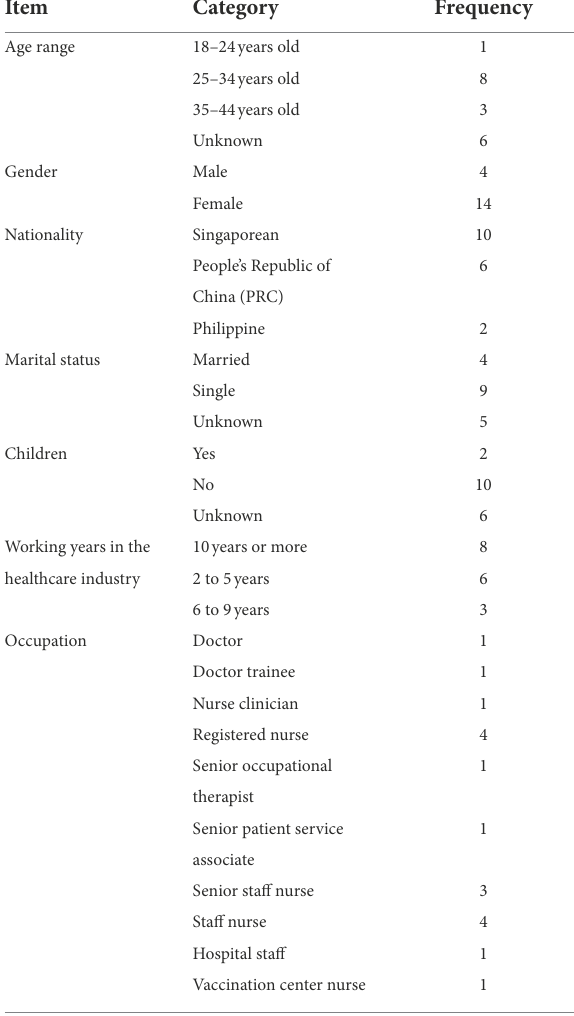
TABLE 1 Participant demographics ( N =